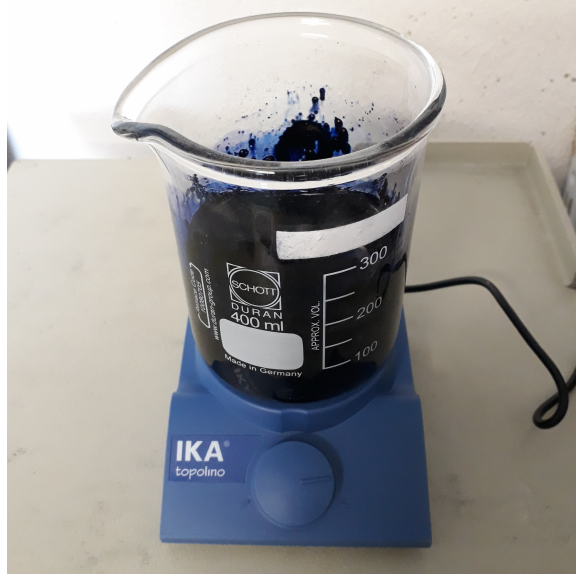
Figure 4. Controlled stirring of MB solution with the tested material